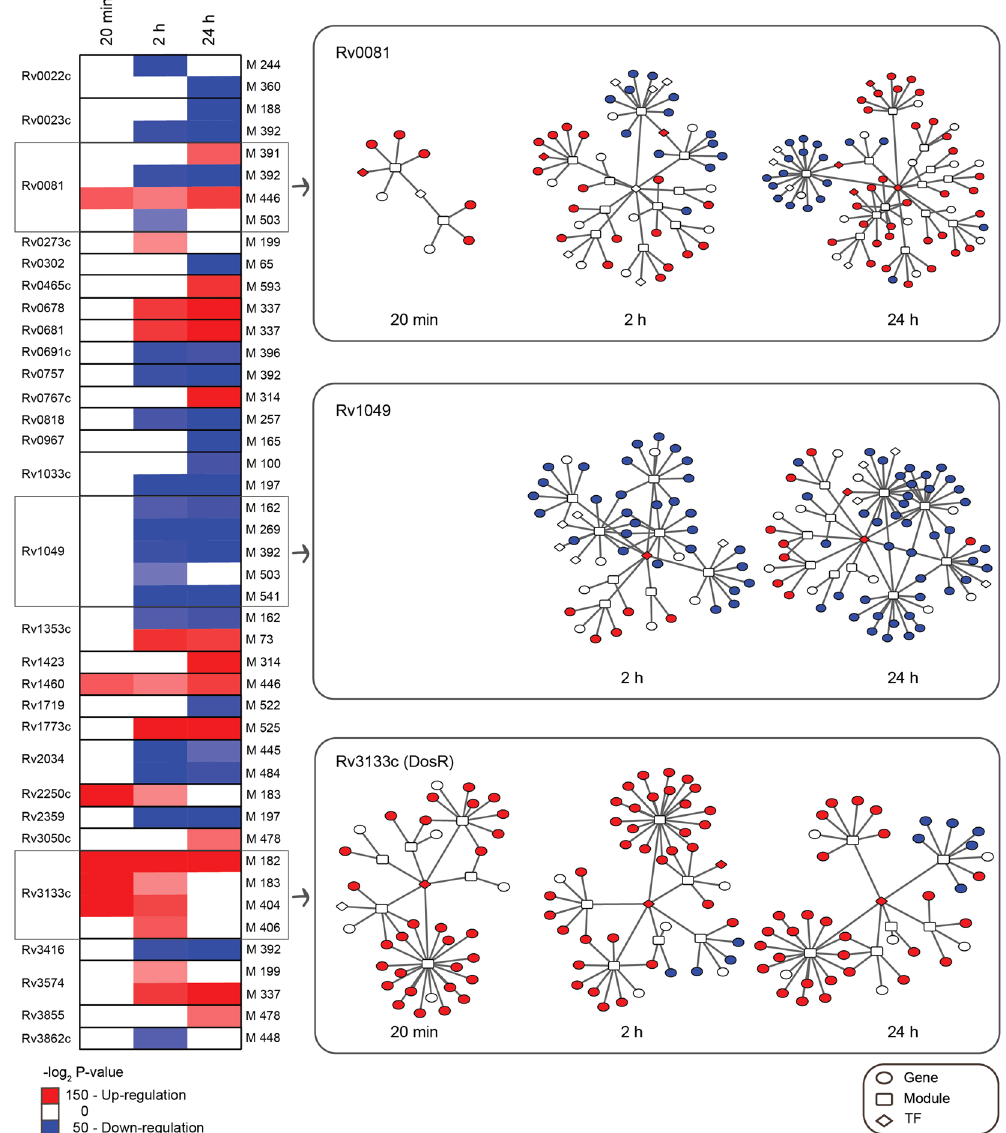
Figure 2. Module-centric view of the transcriptional regulatory network in response to nitric oxide stress. Heat map shows the adjusted and log 2 transformed P-values for the association of a transcription factor with an EGRIN module. Red indicates that a given module is upregulated while blue indicates downregulated modules. White cells denote modules that did not meet the significance threshold to be considered enriched (adjusted P-value < 0.01). For each of the three main transcriptional regulators of the NO stress response, a summary of the sub-networks over time is illustrated. Details such as gene, module and transcription factor names are available in Supplementary Fig.